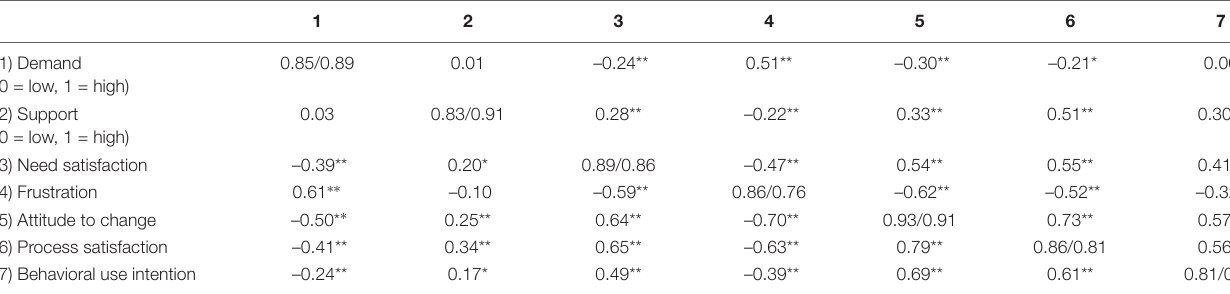
TABLE 5 | Correlation matrix of Study 2 and Study